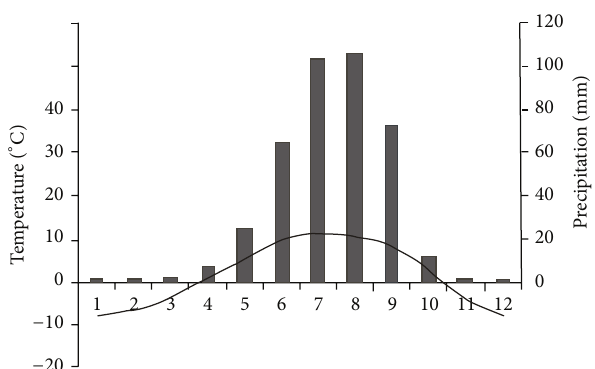
Figure 1: Location of the study area.